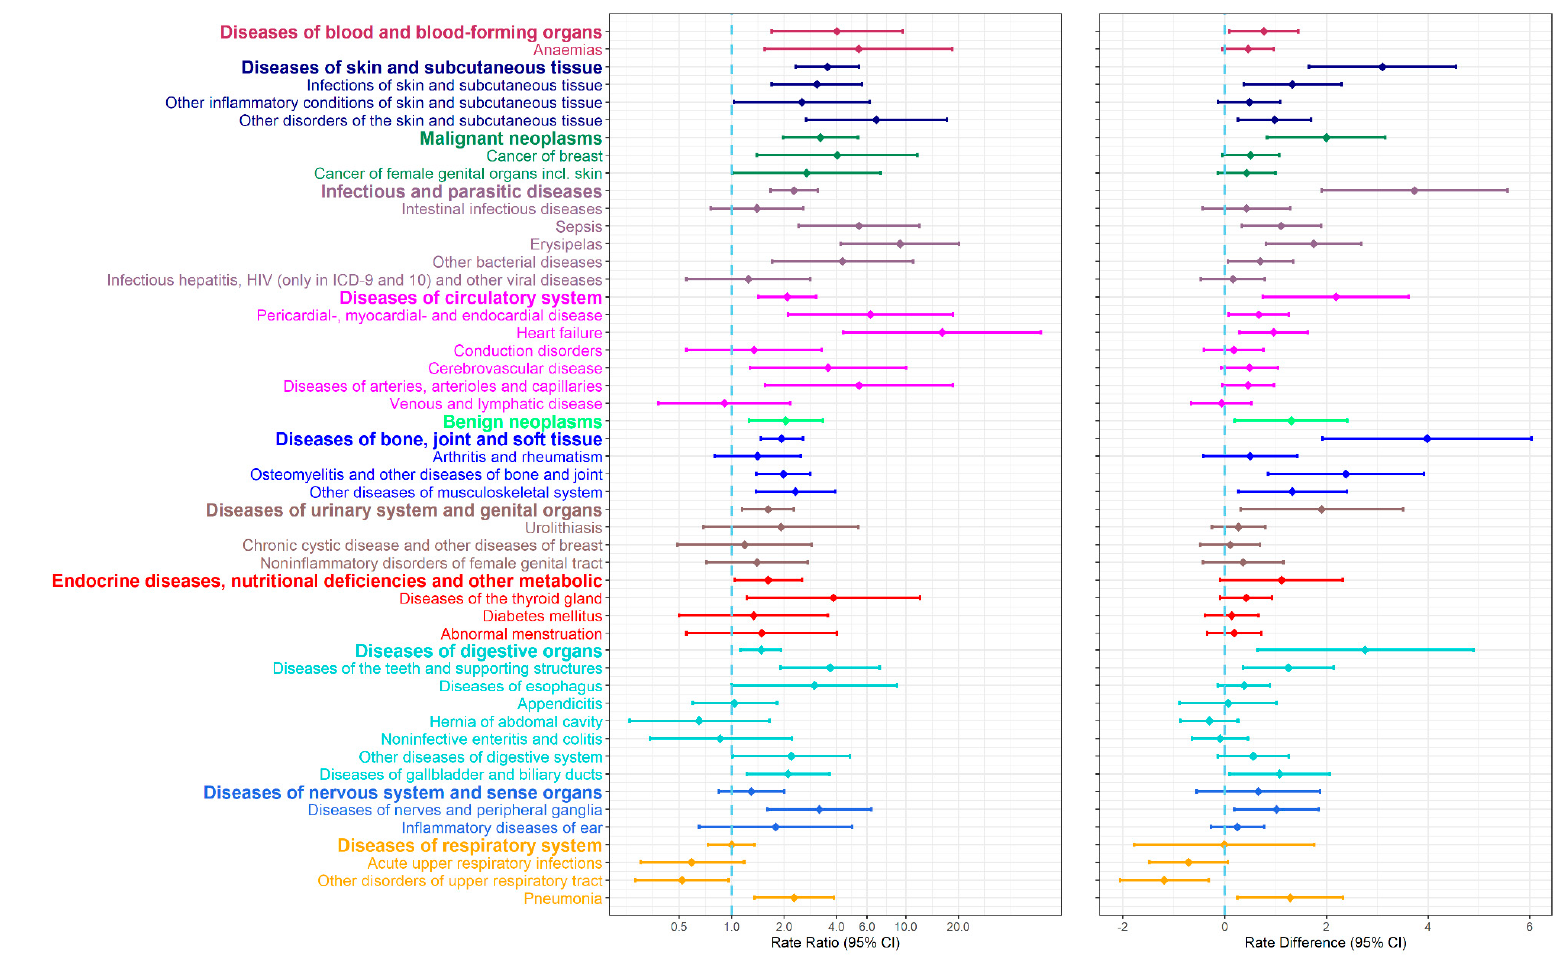
Figure 3. Rate ratios of hospital contacts, rate differences per 1000 person years, and 95% confidence intervals (CIs) for first diagnosis of each of the 120 specific disease categories for survivors compared with the matched comparisons. Only diseases for which survivors had five or more hospital contacts are shown.